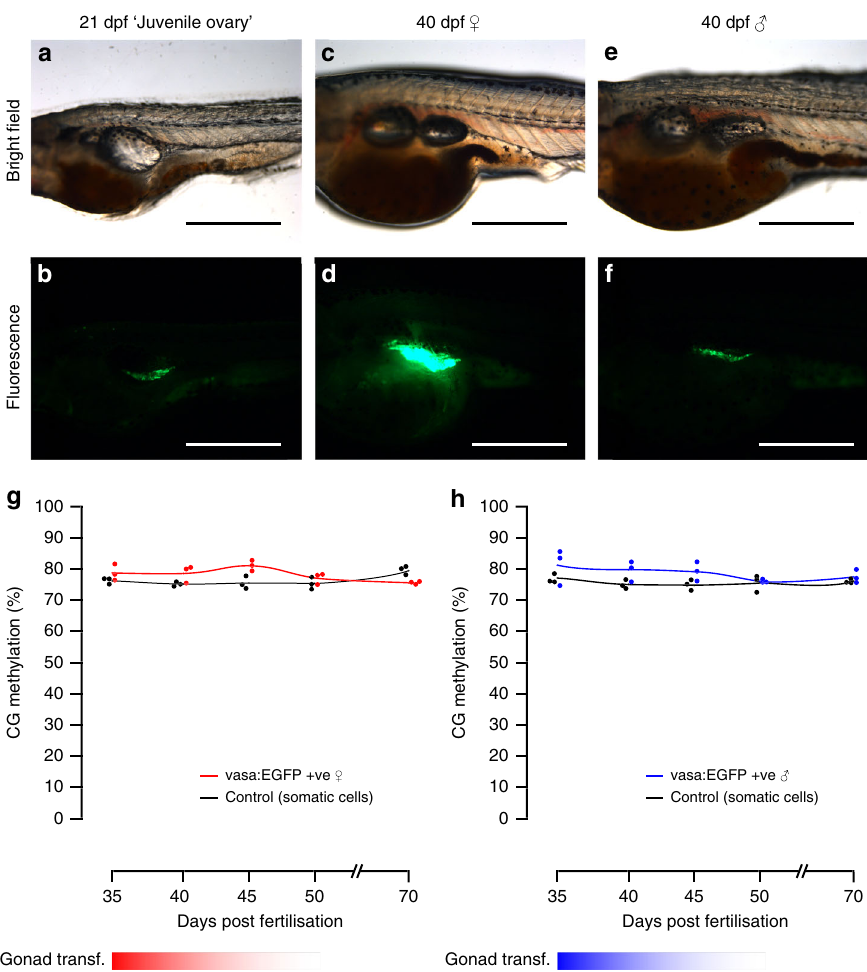
Fig. 2 Fluorescence microscopy of germline cells and their methylation during gonad transformation. a – f Phenotypic sex in zebra fi sh can be identi fi ed using vasa:EGFP expression: during the ‘ juvenile ovary ’ stage, expression of EGFP is low but consistent between individuals ( a , b ). Later, expression of EGFP vastly increases in presumptive females ( c , d ) relative to presumptive males ( e , f ). This enables sex phenotyping in early stages of sexual differentiation. Scale bars are 500 µ m. g , h Methylation in the vasa:EGFP + ve germline cells of female ( g ) and male ( h ) fi sh from the gonad transformation stage until sexual maturity (35 – 70 dpf). Non-germline control cells were also tested (black lines and dots). For each sample type and timepoint, n = 3 independent biological replicates were